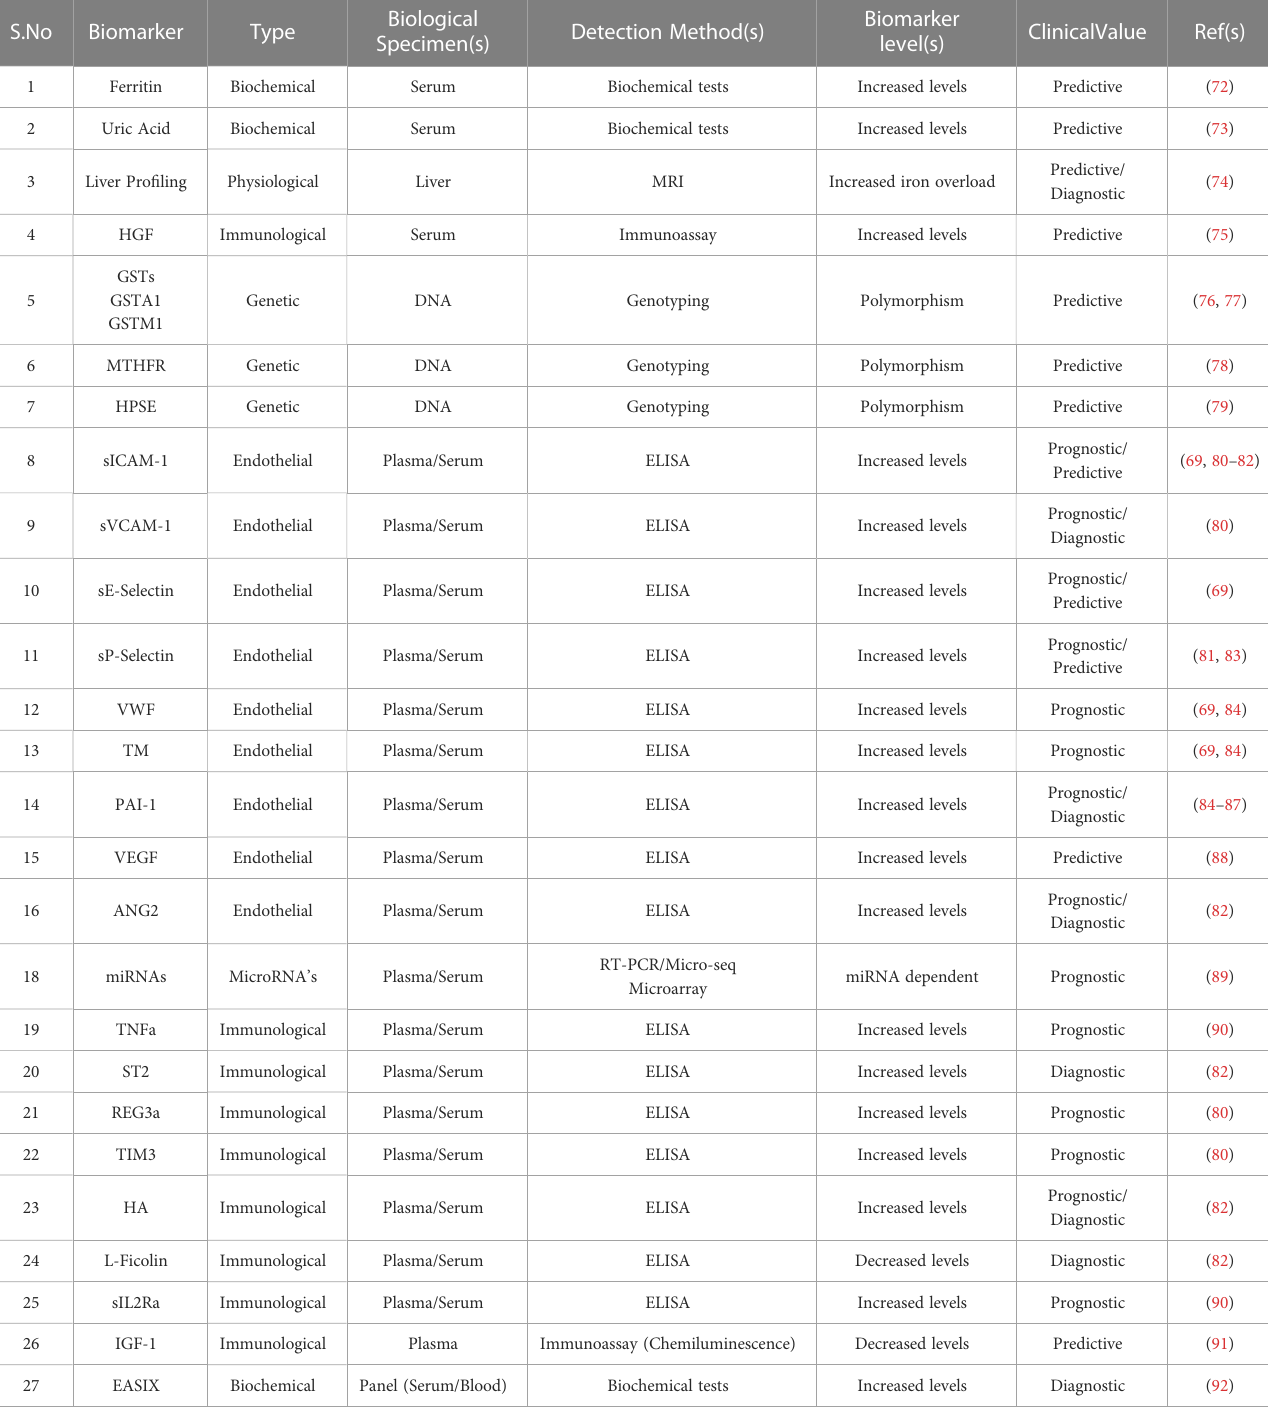
TABLE 2 List of various types of biomarkers with clinical values that could help in the prediction, diagnosis, or prognosis for SOS.